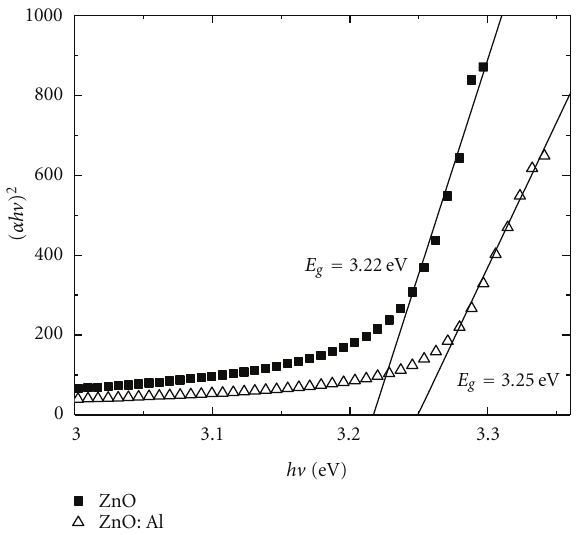
Figure 5: Determination of the band gap of ZnO and ZnO: Al films.